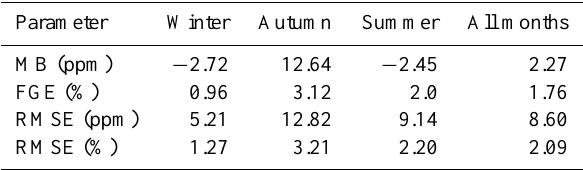
Table 4. Performance matrices used to quantify the level of agree- ment between the model simulations and observations. These statis- tics are based on hourly values for each